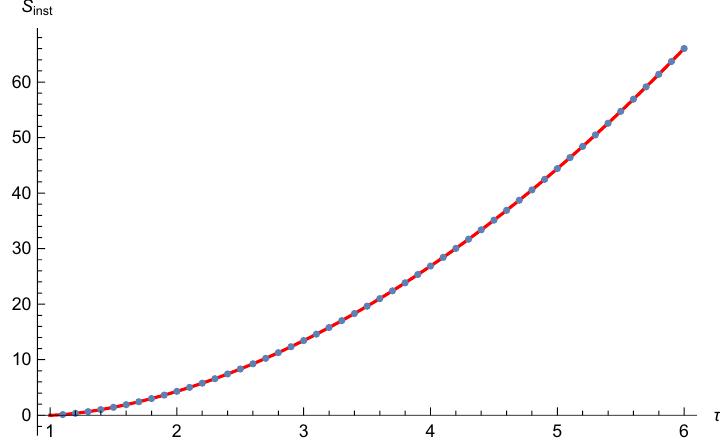
Figure 2 . Plot of the instanton action S inst ( (cid:12); (cid:28) ) for (cid:12) = 5. The dots are the exact values of the right hand side of (5.5) for (cid:12) = 5 ; N = 500, while the red curve represents the analytic form of S inst ( (cid:28) ) at (cid:12) = 0 in